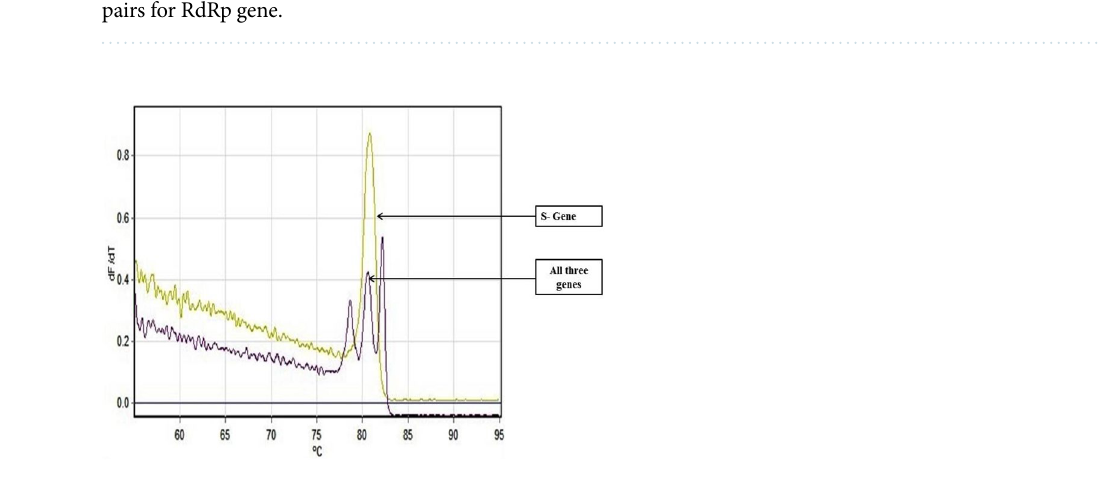
Figure 8. Individual melt curve peak for S gene obtained upon single-plex RT-PCR reaction using primer pairs for S